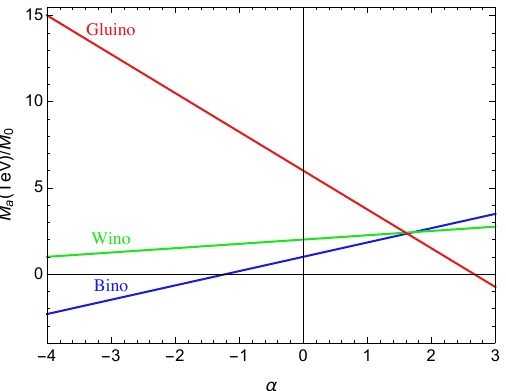
Figure 1 . Gaugino masses at TeV as functions of the α parameter. The masses have been normal- ized by M 0 , which is the pure modulus-mediated contribution at M GUT . The red, green, and blue colored lines correspond to the gluino, wino, and bino masses,